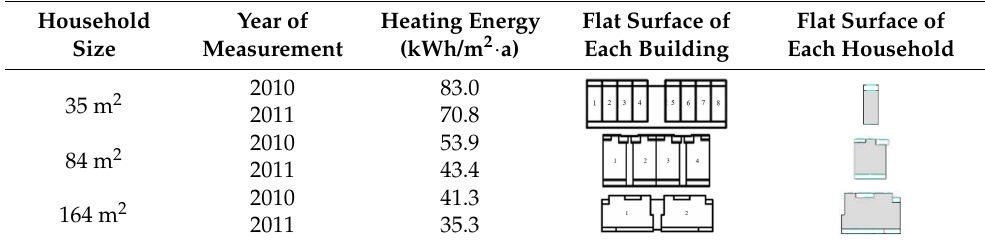
Table 6. Heating energy per unit area as well as flat surface of each household and building according to household